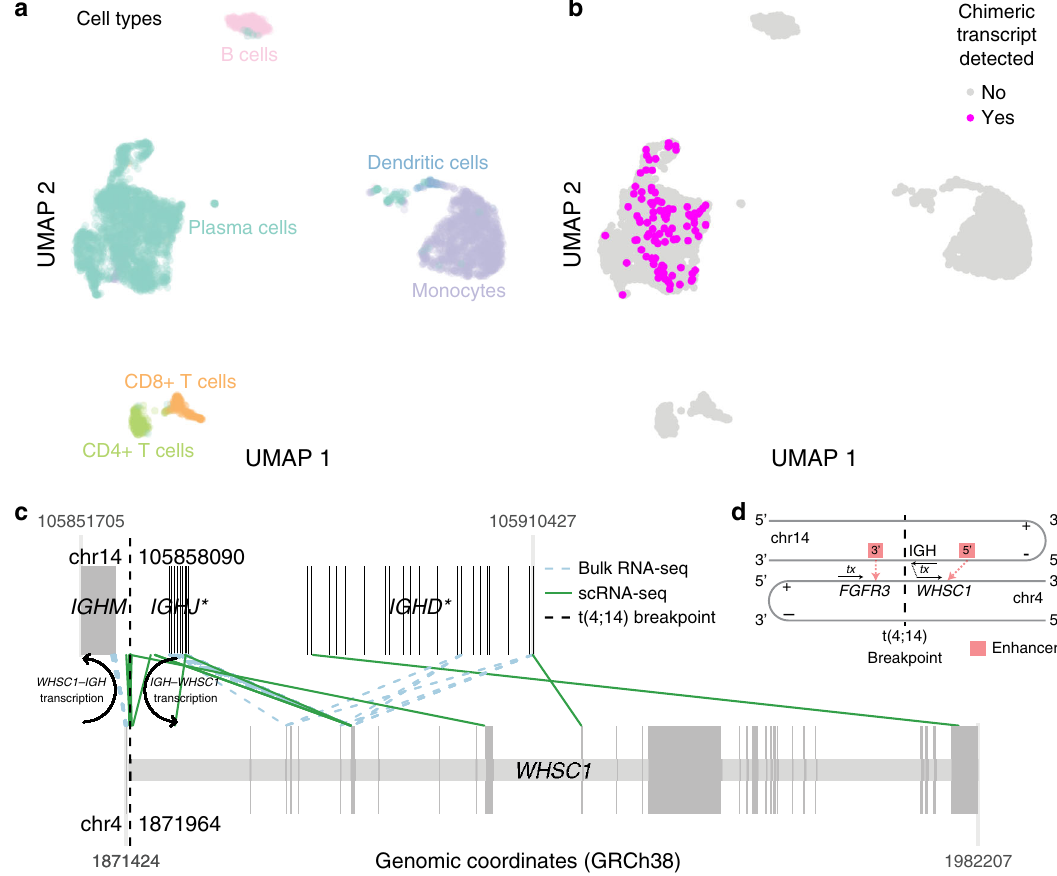
Fig. 4 Single cell chimeric transcript detection. a Cell types present from one patient ′ s scRNA-seq sample (27522 primary disease stage, with t(4;14)). b Cells with chimeric transcripts detected from non-overlap regions. c Mapping location of paired-end (bulk) or same barcode (scRNA-seq) reads. Darker gray boxes indicate exons; lighter gray boxes span gene boundaries. d IGH--WHSC1 fusion transcription model. Source data and scripts are available at https://doi.org/10.6084/m9. fi region) to chr4 (positive strand) ( WHSC1 ) (Fig. 4d). Reads black line) on both chromosomes (chr1) support IGH--WHSC1 .